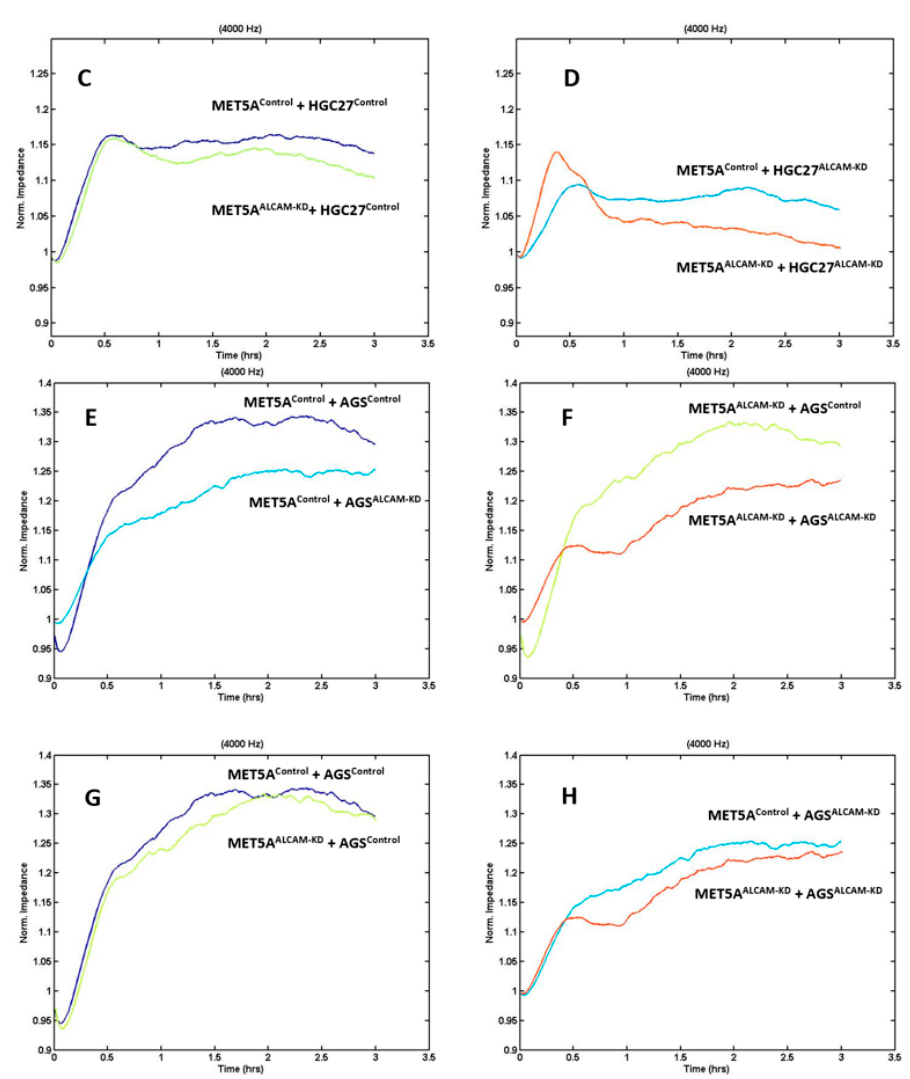
Figure 3. ECIS based evaluation of gastric adhesion to mesothelial cells. ( A - D ): Adhesion of HGC27 cells to MET5A mesothelial cells; ( E - H ): Adhesion of AGS cells to MET5A cells; Shown are monitoring at 4000 Hz. MET5A Control , AGS Control , HGC27 Control : control transfected cells; MET5A ALCAM-KD , AGS ALCAM-KD , HGC27 ALCAM-KD : cells with ALCAM knockdown by way of cell transfection. Replicate n = 4.